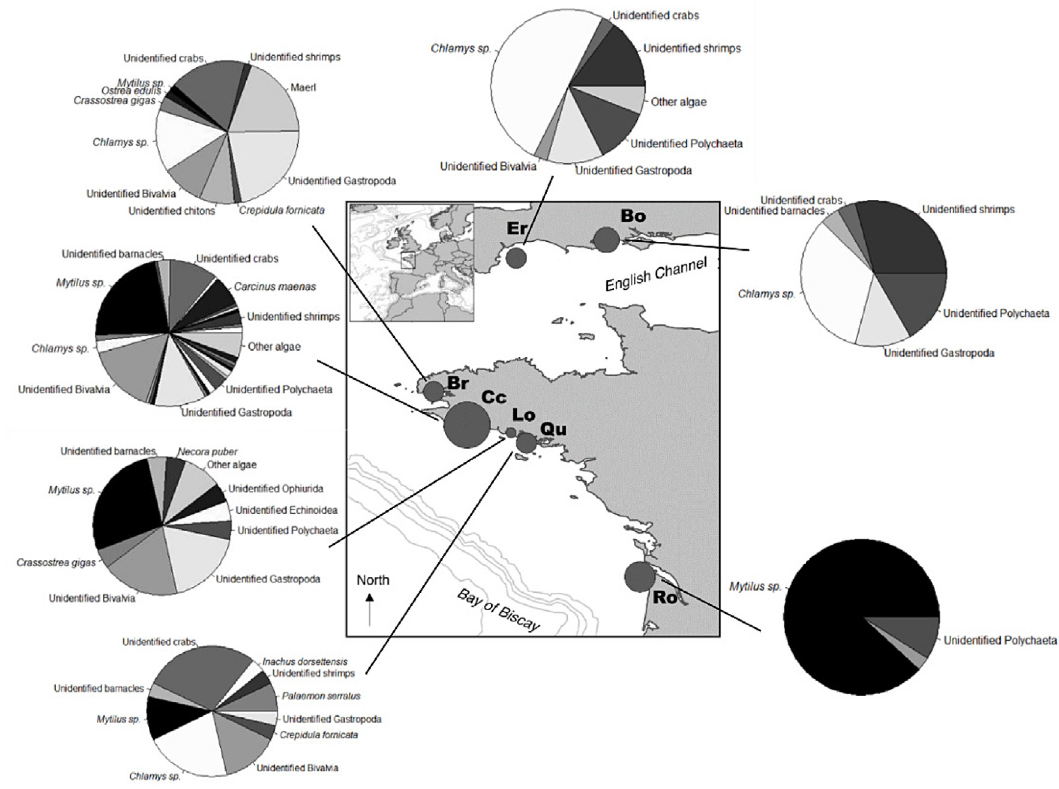
Fig. 1. Sampling site. Circle size is proportional to the number of individuals sampled per site: Bay of Bournemouth (Bo, N = 9), Bay of Torquay (Er, N = 18), Brest (Br, N = 15), Concarneau (Cc, N = 52), Lorient (Lo, N = 6), Quiberon (Qu, N = 12) and Royan (Ro, N = 30). Pie charts show the percentage of frequency of prey occurrence (%F) per sites at the lower taxonomic level. Labels of species indicate whether %F >